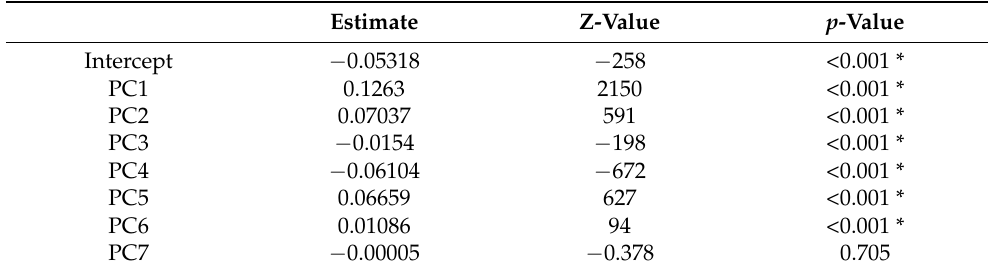
Table 2. Model coefficients and significance levels for the predictor variables (principal components 1 through 7).